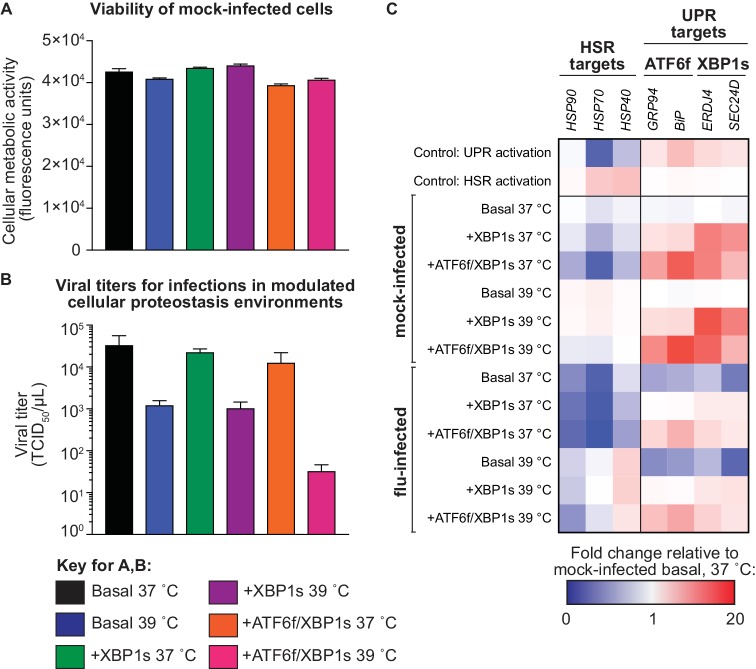
Methods to induce XBP1s and ATF6f/XBP1s are not cytotoxic and are functional during influenza infection.(A) Induction of XBP1s or ATF6f/XBP1s and increased temperature (72 hr) does not alter metabolic activity in the absence of influenza, as measured by a resazurin assay. (B) Wild-type WSN/1933 influenza titers (determined by TCID50 assay) from infections in modulated cellular environments (MOI = 0.01; 48 hr post-infection). For A–B, the average of biological triplicates is plotted with error bars representing the SEM. (C) Fold change of heat shock response (HSR) and unfolded protein response (UPR) gene transcripts in modulated ER proteostasis environments with and without influenza (MOI = 1, 8 hr post-infection), relative to a mock-infected basal environment at 37˚C. UPR gene transcripts are designated as ATF6f or XBP1s targets based on prior studies (Shoulders et al., 2013). Positive controls for activating the UPR (treatment with the N-glycosylation inhibitor tunicamycin) and the heat shock response (HSR) (treatment with arsenite to induce oxidative stress) are shown. Figure 2—source data 3. Fold-change of HSR and UPR targets during influenza infection.